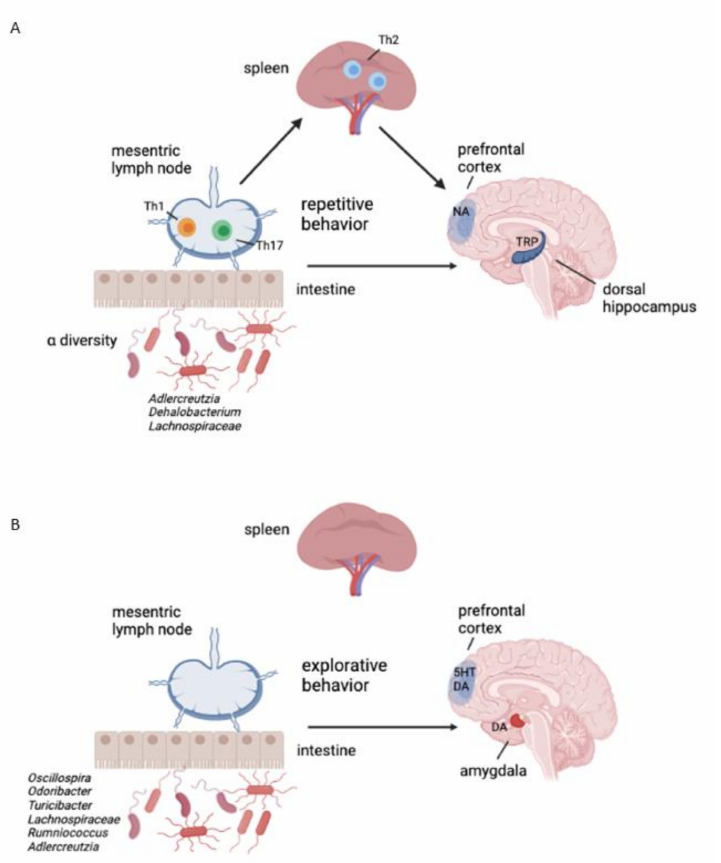
Figure 11. Indications of which feature combination significantly influence repetitive and anxiety-like behaviour and explorative behaviour evaluated by marble burying ( A ) and open field behaviour ( B ) tests, respectively. ( A ) The alpha-diversity and relative abundances of the genera Adlercreutzia and Dehalobacterium, changes in Th1 and Th17 cells in MLN, changes in activated Th2 cells in spleen, and tryptophan levels in dorsal hippocampus significantly predict changes in repetitive behaviour. ( B ) The relative abundances of the genera Oscillospira, Ruminococcus, Odoribacter, Turibacter, Lachnospiraceae other/Unclassified and Adlercreutzia and changes in serotonin and dopamine metabolism in PFC and amygdala significantly predict changes in explorative